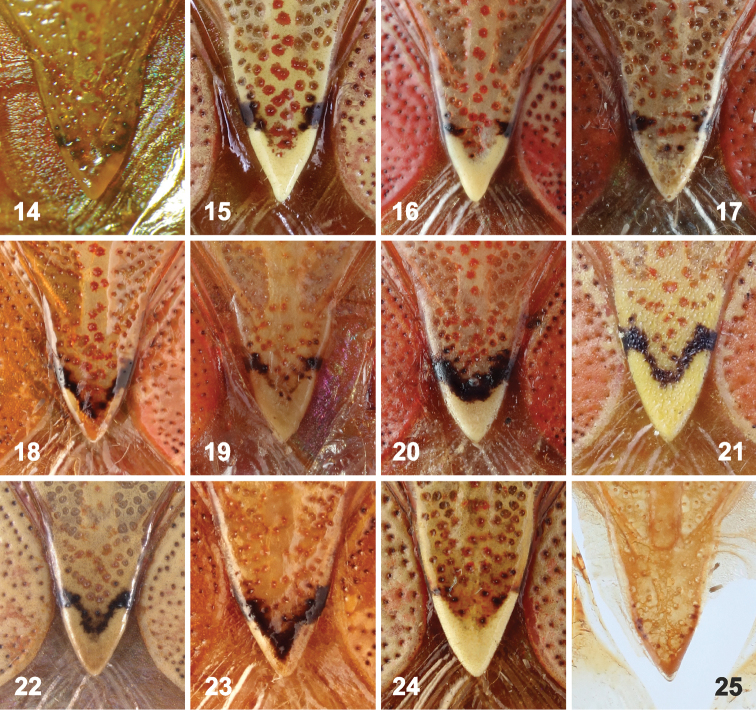
Apex of scutellum of Rhyncholepta species. 14–18Rh.grandicallosagrandicallosa Bergroth, 1911: 14 – ♀, lectotype, French Guiana 15 ♂, candidate neotype, French Guiana, Camp Caimans 16 ♂, French Guiana, Camp Voltaire 17–18 French Guiana, Camp Caimans (17 ♀, 18 ♂). 19–22Rh.grandicallosacentroamericana subsp. n.: 19 ♀, Panama, Barra del Colorado 20 ♀, Costa Rica, Rancho Quemado 21 ♂, Panama, Pipeline Road 22 Guatemala, Firmeza. 23Rh.henryi sp. n., holotype, ♂, French Guiana, Camp Caimans. 24Rh.meinanderi Becker & Grazia-Vieira, 1971, ♂, Ecuador, Arajuno env. 25Rh.wheeleri sp. n., holotype, ♂, Guyana. (photographs 14 A. Albrecht; 15– 21, 23–25 P. Kment; 22 J.E. Eger)